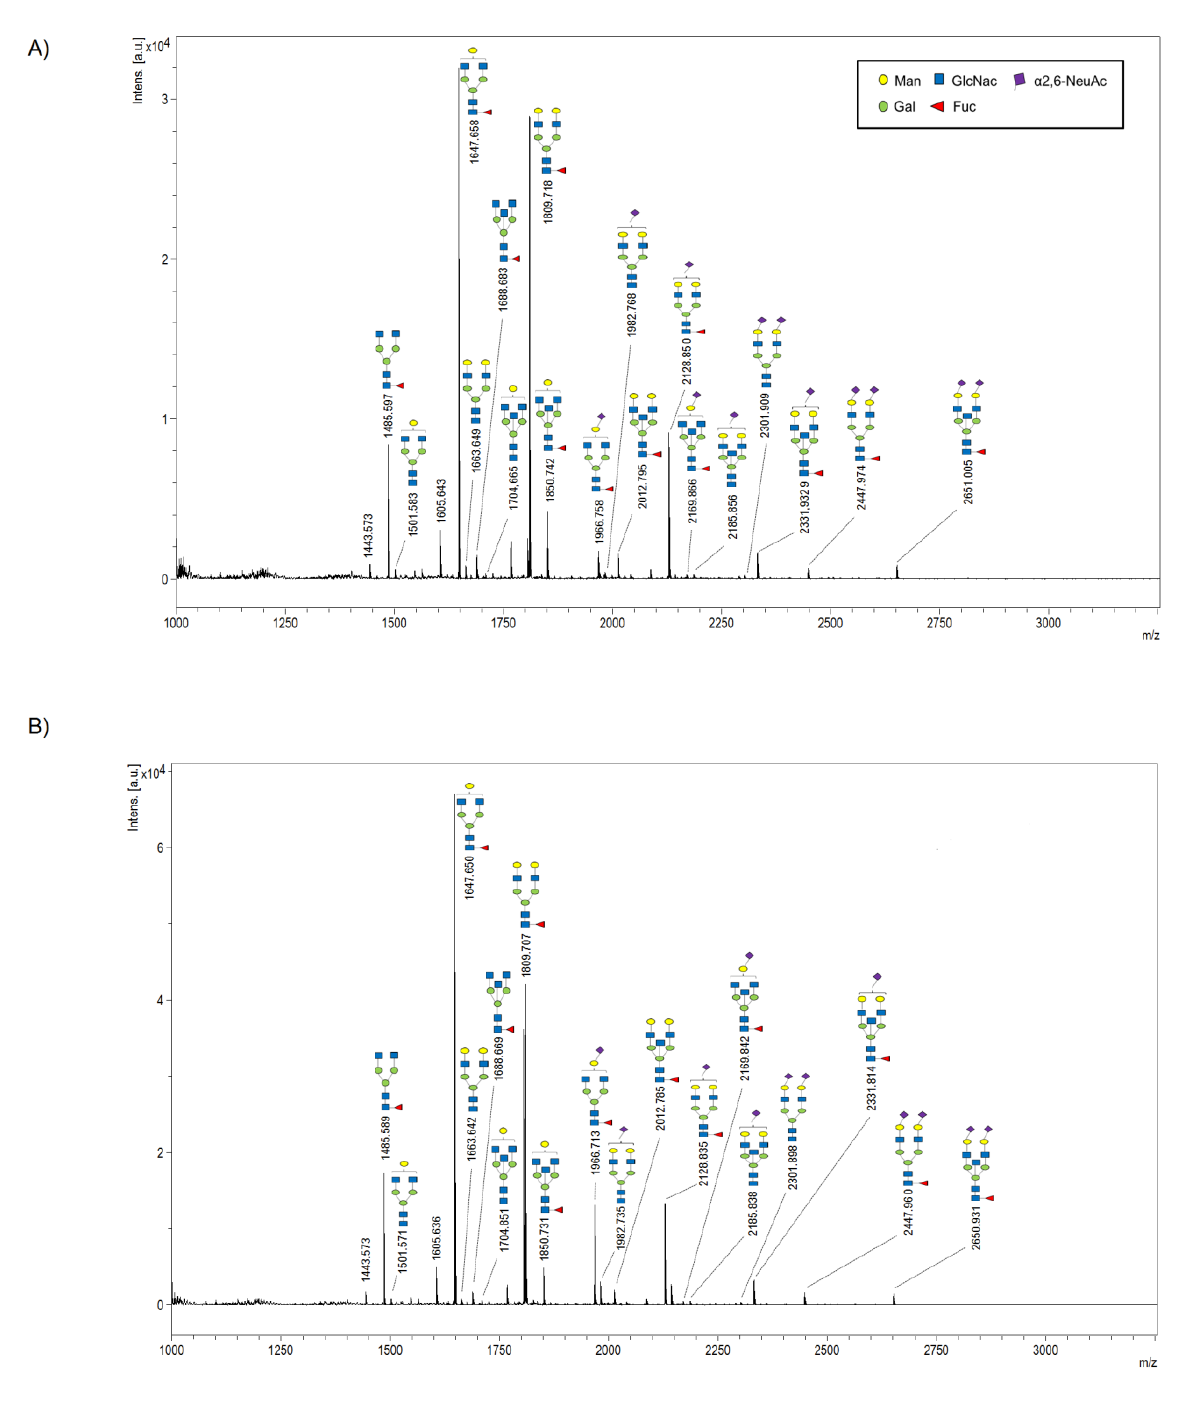
Figure 2: Representative MALDI-TOF-MS spectra of released and derivatised N-glycans (including their monoisotopic masses) obtained from IgG samples isolated from FF of (A) MNC and (B) COH groups of patients. Displayed N-glycan structures are given based on their observed masses and literature [49]. Abbreviations: Man, mannose; Gal, galactose; Fuc, fucose; GlcNac, N-Acetylglucosamine; α 2,6- NeuAc, α 2,6 – linked sialic acid; α 2,3- NeuAc, α 2,3-linked sialic